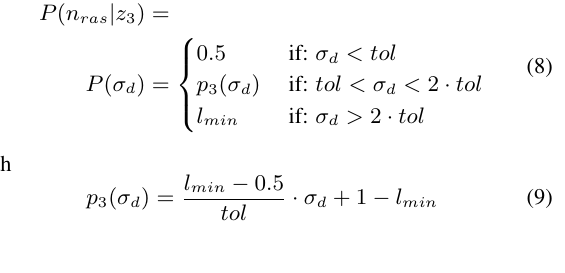
Figure 7. As-planned model in triangle representation for time step 2 on 27